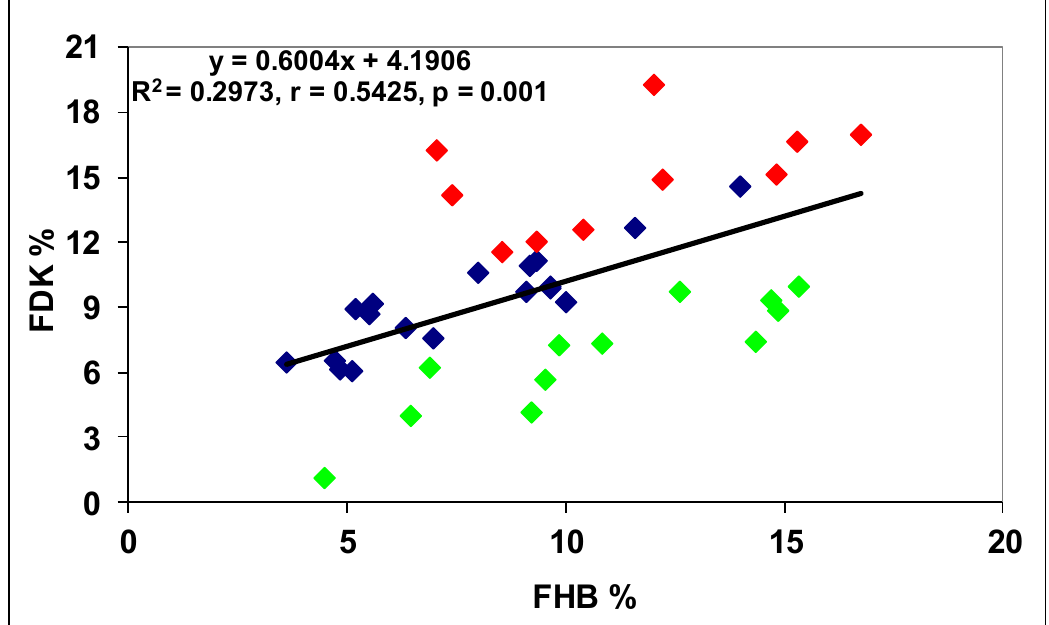
Figure 11. DI and FDK regression in FHB resistance tests in winter wheat genotypes against two F. graminearum and two F. culmorum strains, 2009–2012. Red data: FDK overproduction, data from the regression line are farer than the LSD 5% 1.66 to the larger DON concentrations; green data: resistance to kernel infection, data from the regression line are farer than the LSD 5% 1.66 to the lower DON concentrations. LSD 5%: for FDK is 1.66 [26].